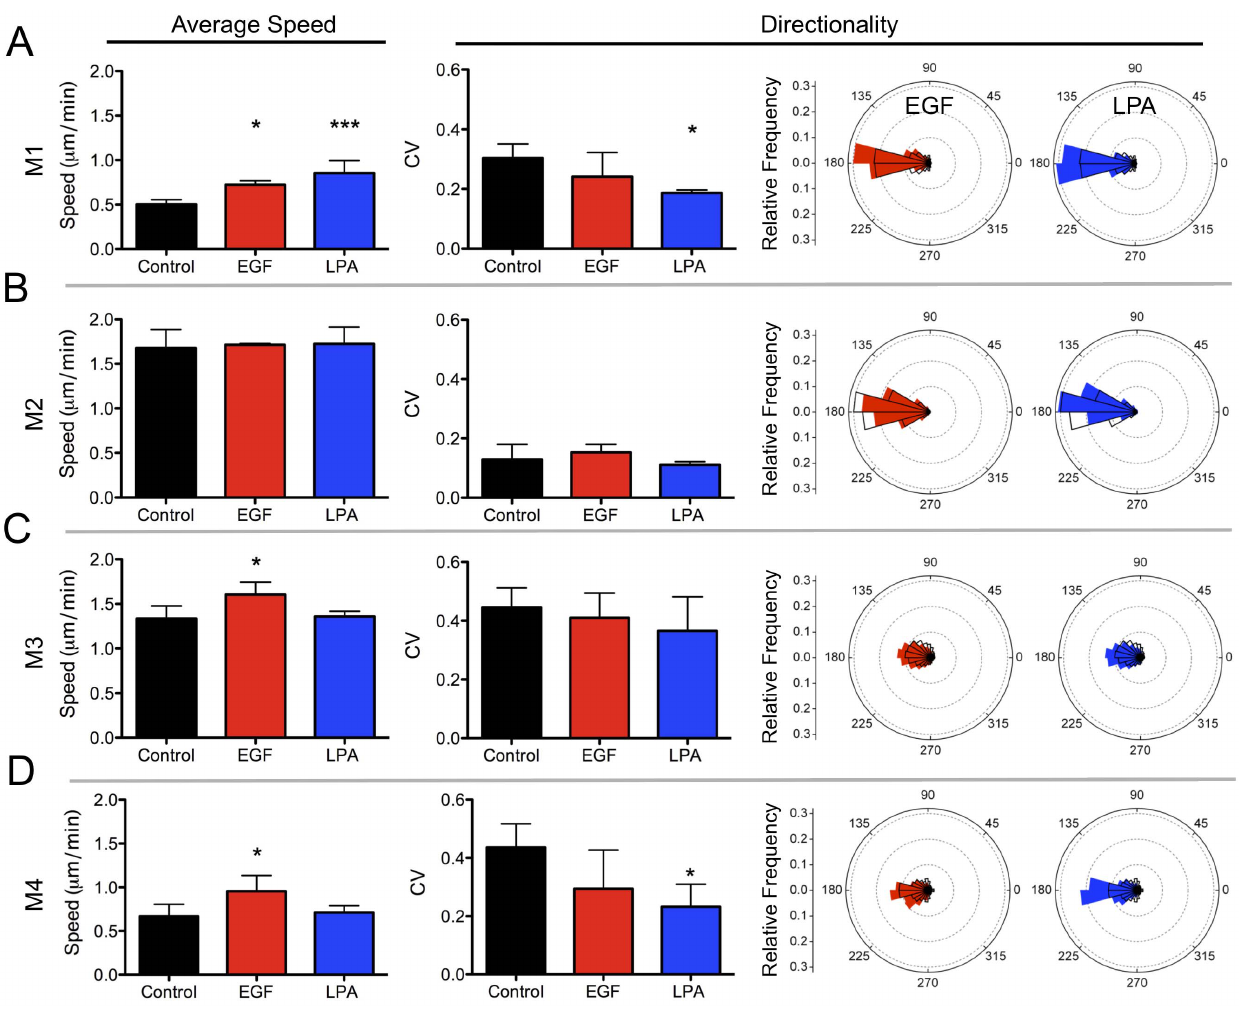
Figure 3. Cell lines of the MCF10A series show distinct responses to EGF and LPA. ( A–D ) M1–M4 cells were stimulated with 5 ng/mL EGF (red) or 1 m M LPA (blue) and perturbations of average speed and of directionality (angle distributions and CV) compared to controls (black) were assessed (mean 6 SD). Rose plots depict controls (unfilled, black bars) and 5 ng/mL EGF (filled, red bars) or 1 m M LPA (filled, blue bars). Statistical significance: * p , 0.05, ** p , 0.01, *** p , 0.001 (Tukey-Kramer test, n=3 for all conditions except M2 with EGF where n=2). All comparisons were made with M1 cells unless indicated by pairing-brackets.